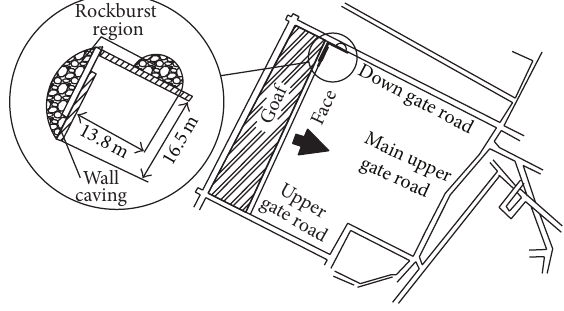
Figure 11: Rockburst region at the early stage of the extraction.